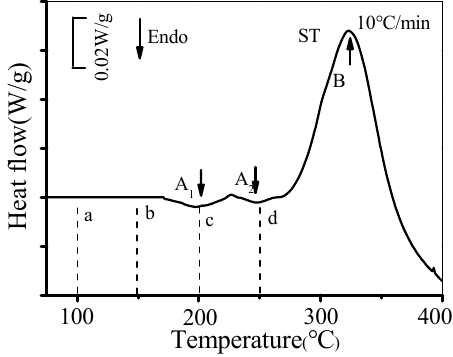
Figure 7. Differential scanning calorimetry (DSC) curves of the solution-treated alloy.